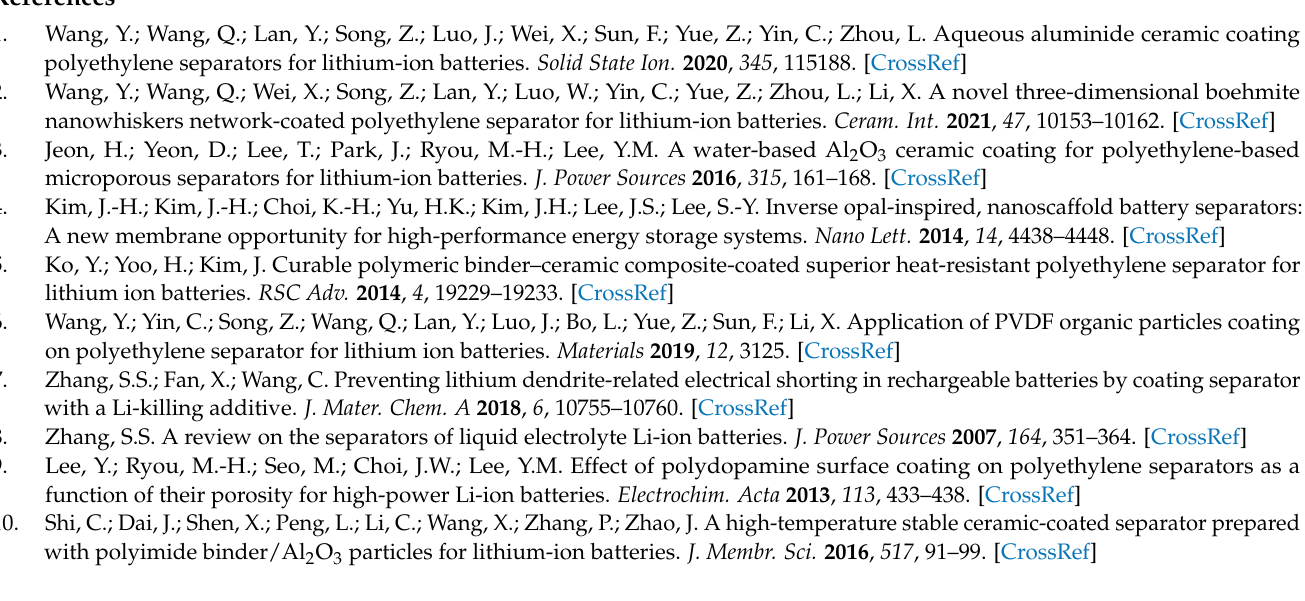
C. Table S1. Summary of results for optimization of the amount of DLSS for stabilization evaluation of Al 2 O 3 slurries corresponding to Figure 1b. Table S2. Instability index and sedimentation velocity of slurries according to different mixing sequences corresponding to Figure